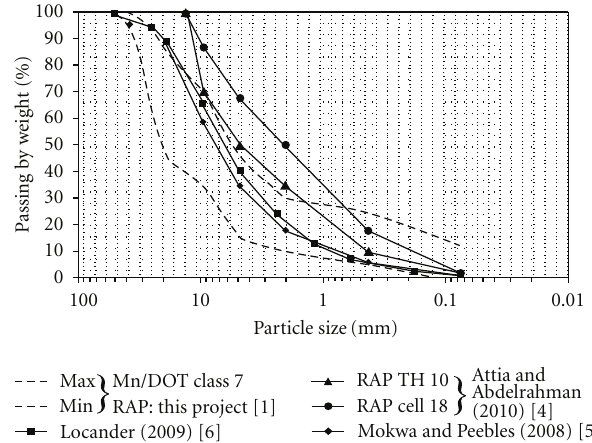
Figure 6: Comparison of Minnesota Department of Transportation (Mn/DOT) class 7 Particle Size Gradation Specification (RAP Used in This project) with Tested RAP Gradations from Selected